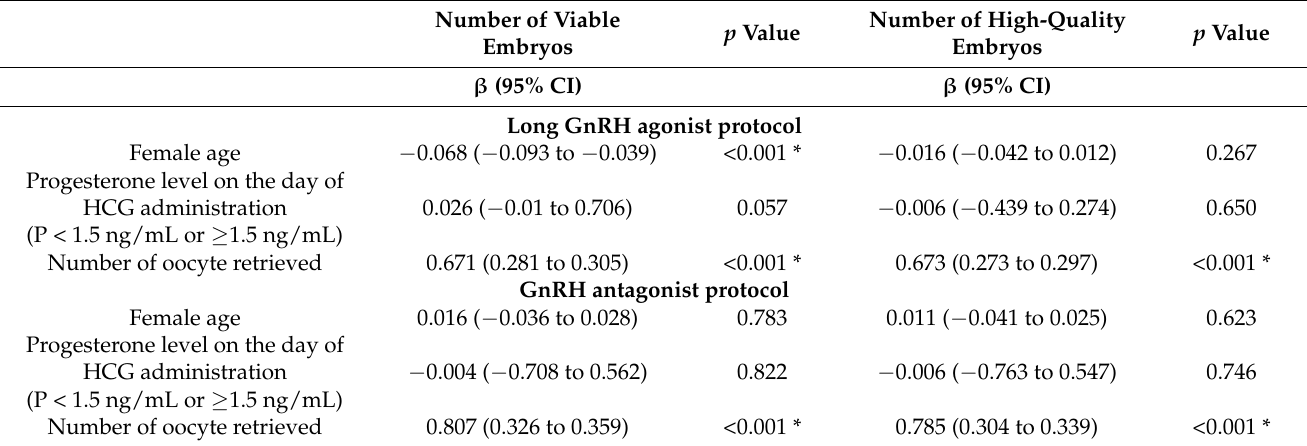
Table 3. Results of multiple regression analysis of embryo